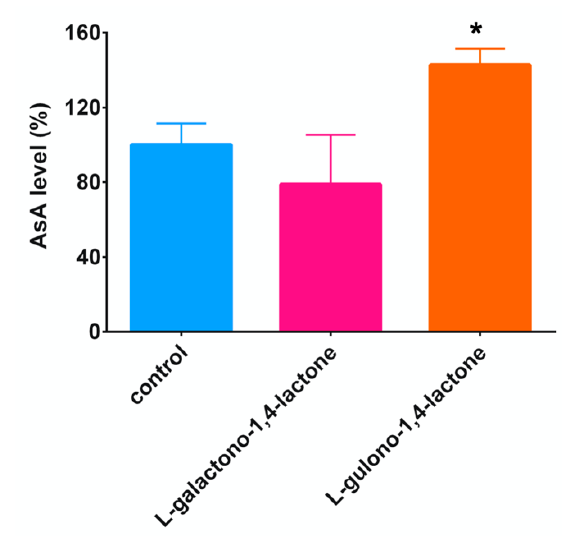
Figure 3. Effect of the addition of L-gulono-1,4-lacton or L-galactono-1,4-lacton on AsA level in worms. AsA level was measured as described in Materials and Methods. Data are expressed as percentages of the values in the liposome-fed worms, used as a control. All values represent mean ± SD of three independent experiments. Asterisks indicate that the values are significantly different from those in the control worms ( p < 0.05).